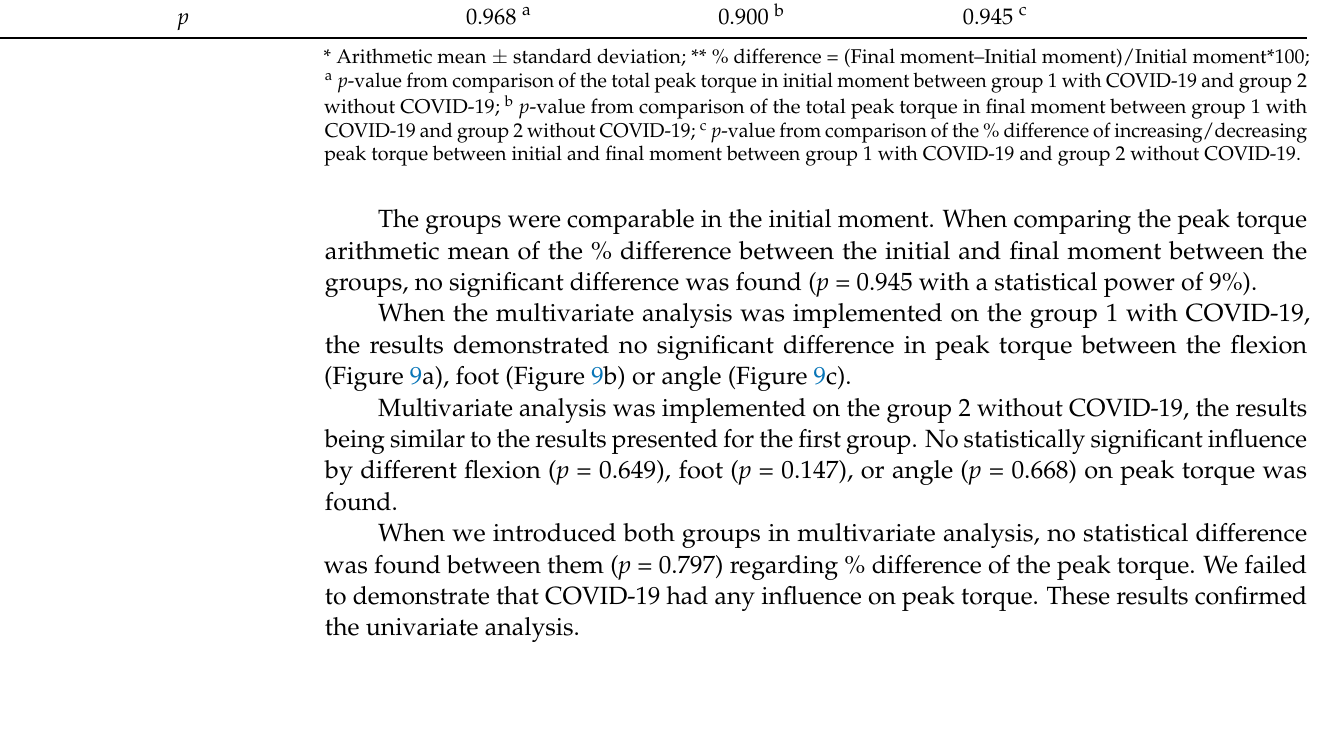
Table 2. Mean peak torque (Nm) during MVIC for study groups in initial and final moment.